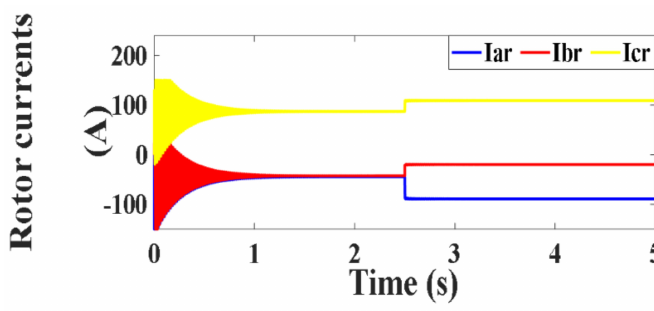
Figure 22. Rotor currents under SVOC (A).